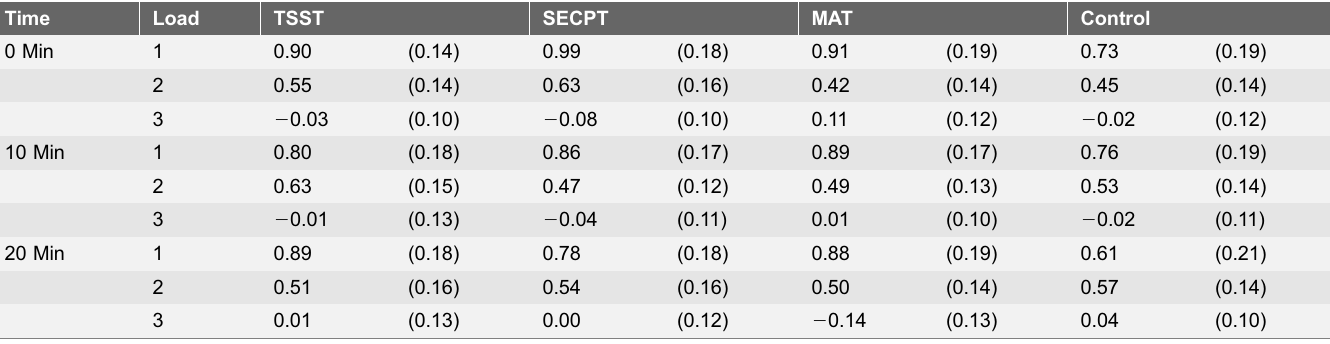
Table 4. N-Back Sensitivity ( d 9 ) as a function of Stress and Load (means and SE) at baseline and 0-, 10- and 20-minutes post-stress. Time Load TSST SECPT MAT